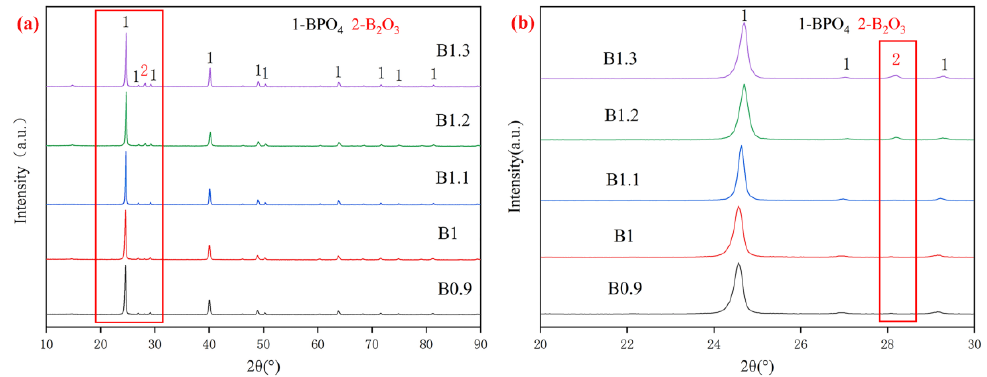
Figure 1. ( a )XRD pattern of BPO 4 precursor and ( b )partially enlarged image of the area enclosed by the red rectangle in ( a ).